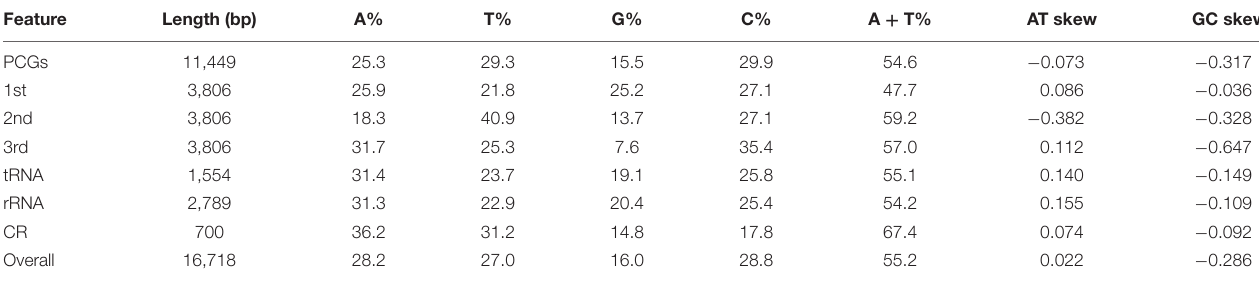
TABLE 1 | Base composition of the Eleutheronema rhadinum